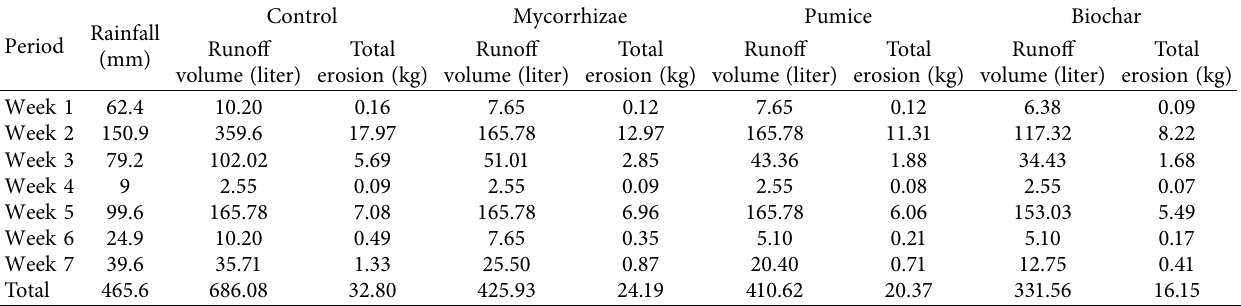
Table 2: Results of runoff and erosion measurements on each erosion